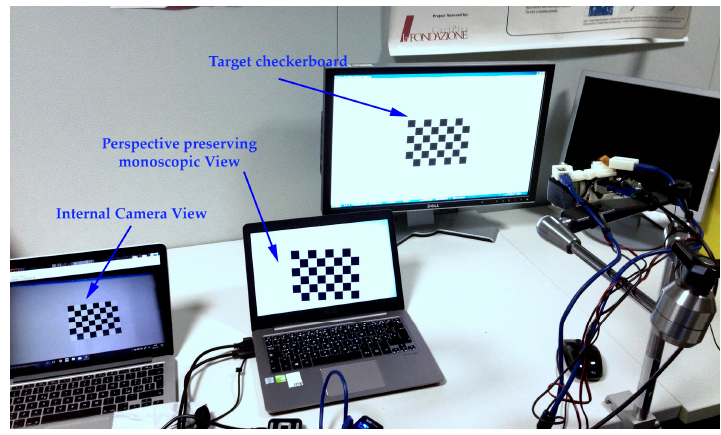
Figure 4. Experimental setup for measuring the monoscopic disparities. The same target checkerboard was used also for the user-specific homography refinement.